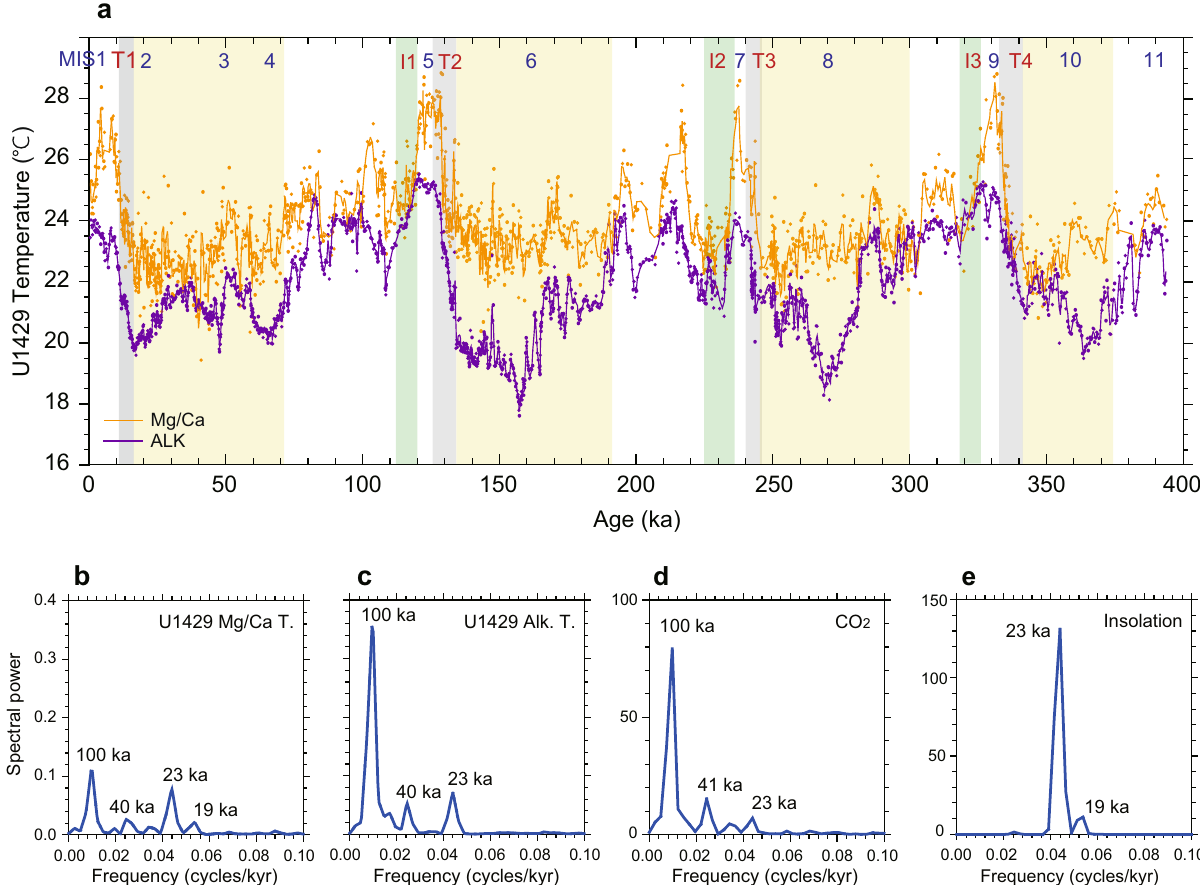
Fig. 1 Reconstructed north-western Paci fi c sea surface temperature. a Alkenone-based temperature record for Site U1429 (three-point running mean, purple line) and G. ruber Mg/Ca temperature record for Site U1429 (three-point running mean, orange line) over the past 400 kyr. Power spectral density of b G. ruber Mg/Ca temperature, c alkenone temperature, d Antarctic composite CO 2 concentration 49 (Antarctic Ice Core Chronology 2012 age model), and e orbital insolation at the latitude of 31.6°N. Yellow, grey, and green shaded areas indicate the glacial period, termination, and inception, respectively. Glacial inception periods are denoted as I1, I2, and I3 3 , and glacial termination periods are indicated as T1, T2, T3, and T4 23